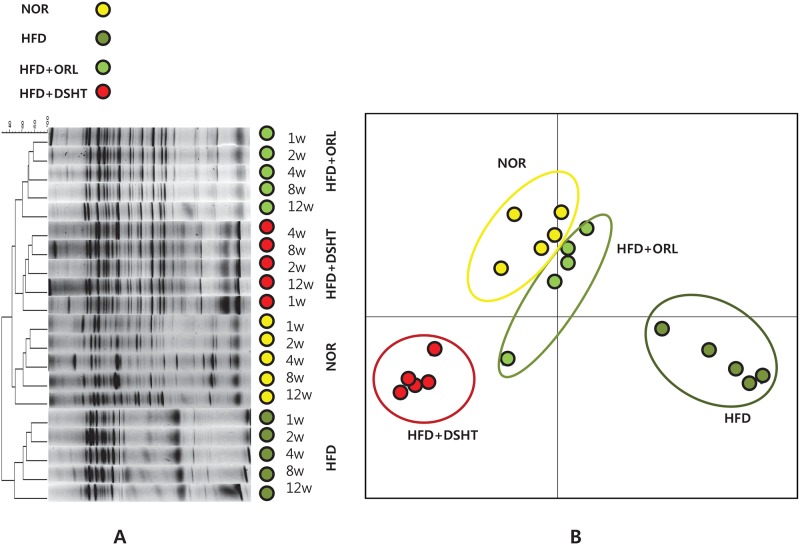
PCR-denaturing gradient gel electrophoresis (DGGE) fingerprinting, and PCA analysis of different microbial flora in mice stool.(A) Banding patters and clustering obtained from PCR-DGGE fingerprinting of mice stool DNA of Normal, HFD, ORL and DSHT. (B) PCA analysis of PCR-DGGE data based on distance matrix showing the similarity between bacterial communities.